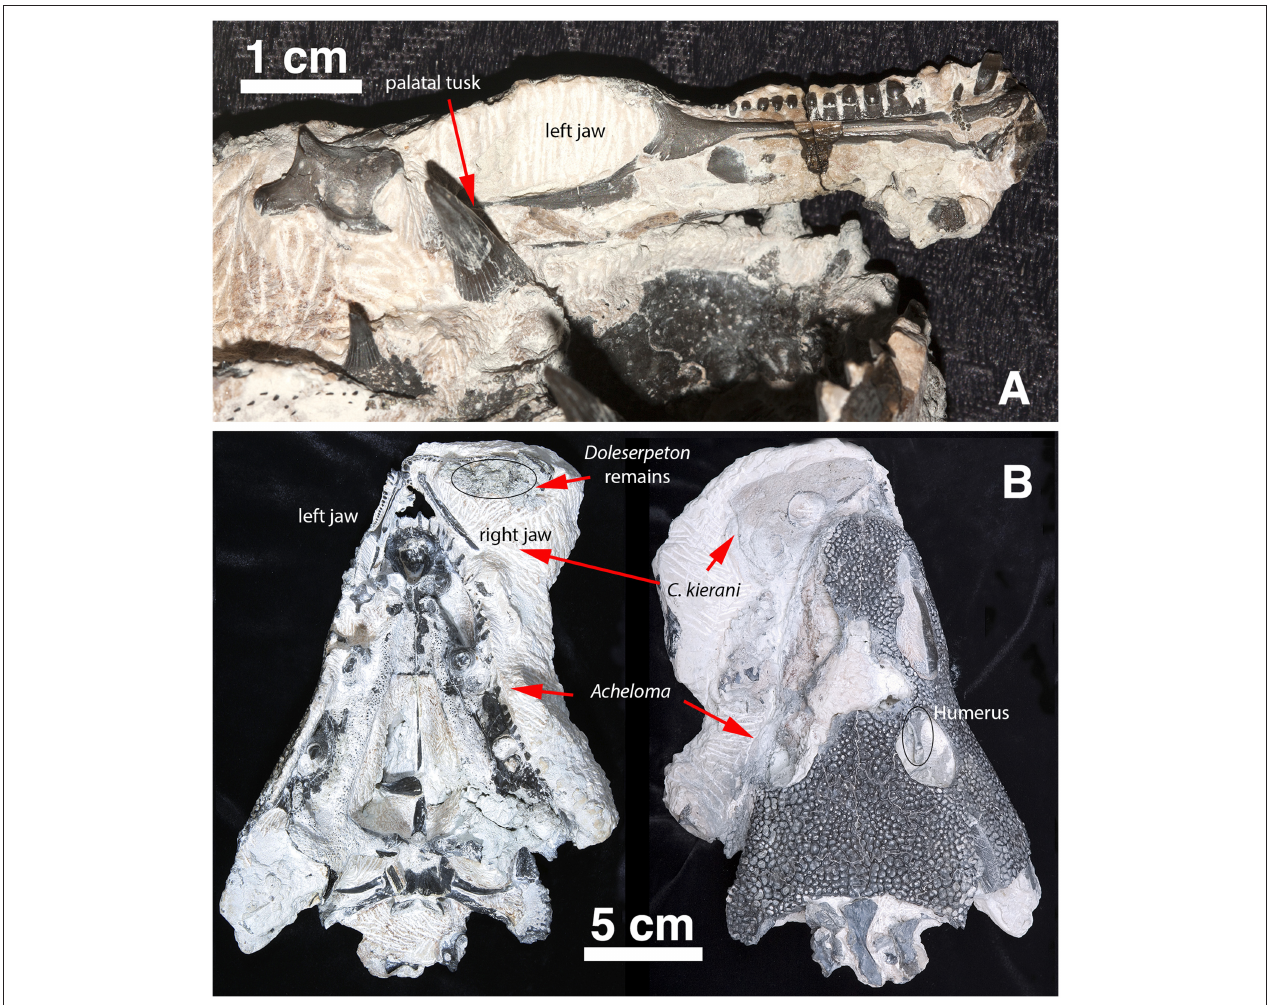
FIGURE 2 | Captorhinus Kierani in association with Acheloma as collected. (A) Left lower jaw of Captorhinus kierani as preserved in association with the anamniote Acheloma . Note the large fang (left foreground) lying mesial to the posterior region of the lower jaw of the holotype. (B) C. kierani and Acheloma in situ in ventral (left) and dorsal (right) aspect. Note the left humerus of C. kierani showing through the orbit of Acheloma in image (B) as viewed dorsally.